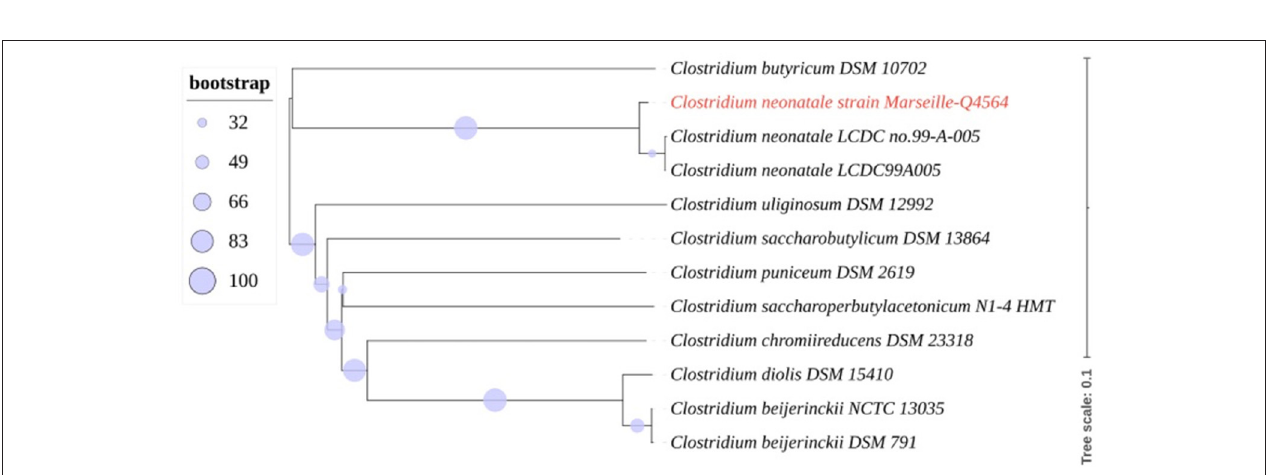
FIGURE 2 | Whole-genome (nucleotides) based phylogenetic tree highlighting the position of C. neonatale strain Marseille-Q4564 relative to other closely related bacterial taxa.